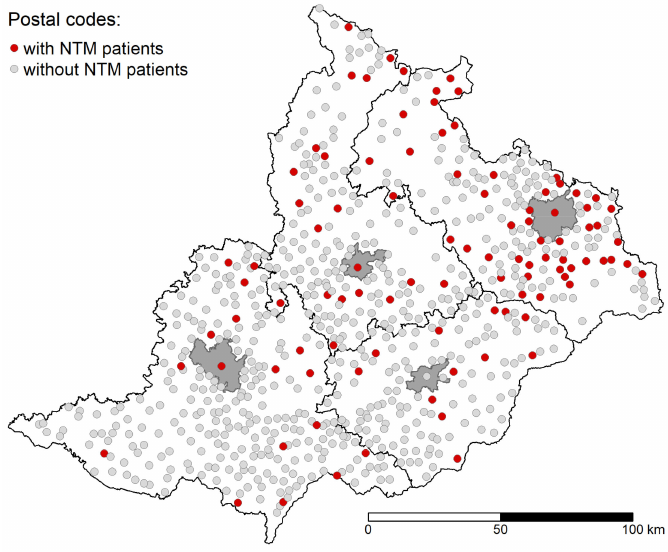
Figure 2. Postal codes within the studied area. Postal codes, from where non-tuberculous mycobacteria (NTM) patients originated are colored